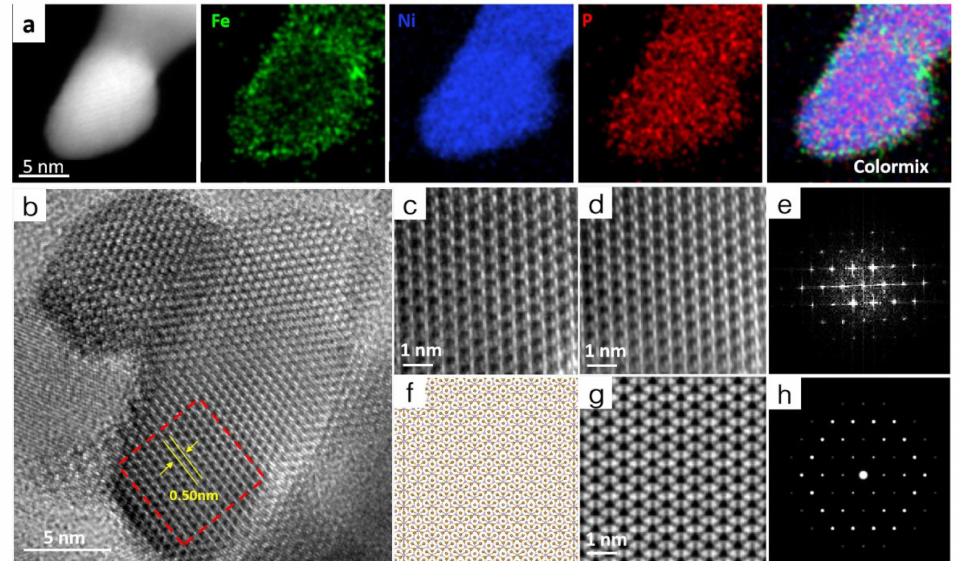
Figure 2. ( a ) HAADF-STEM and the corresponding EDS mapping images of Ni 2 P@Fe 2 P. ( b ) High- magnification TEM image of Ni 2 P@Fe 2 P heterostructure. ( c ) Select-area HRTEM view of the crys- talline region of Ni 2 P. ( d ) Denoised image of Figure 2c. ( f ) The crystal structure model of Ni 2 P observed along the [001] axis. ( g ) The projected potential of Ni 2 P observing along the [001] axis. ( e ) FFT of Figure 2d and ( h ) simulated FFT of the crystal structure model of Ni 2 P observed along the [001]